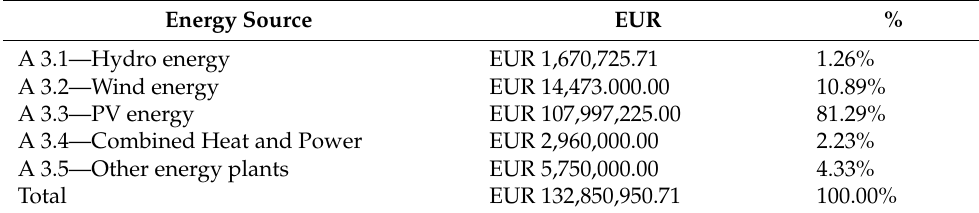
Table 11. Economic budget for SEAPs RES plants.